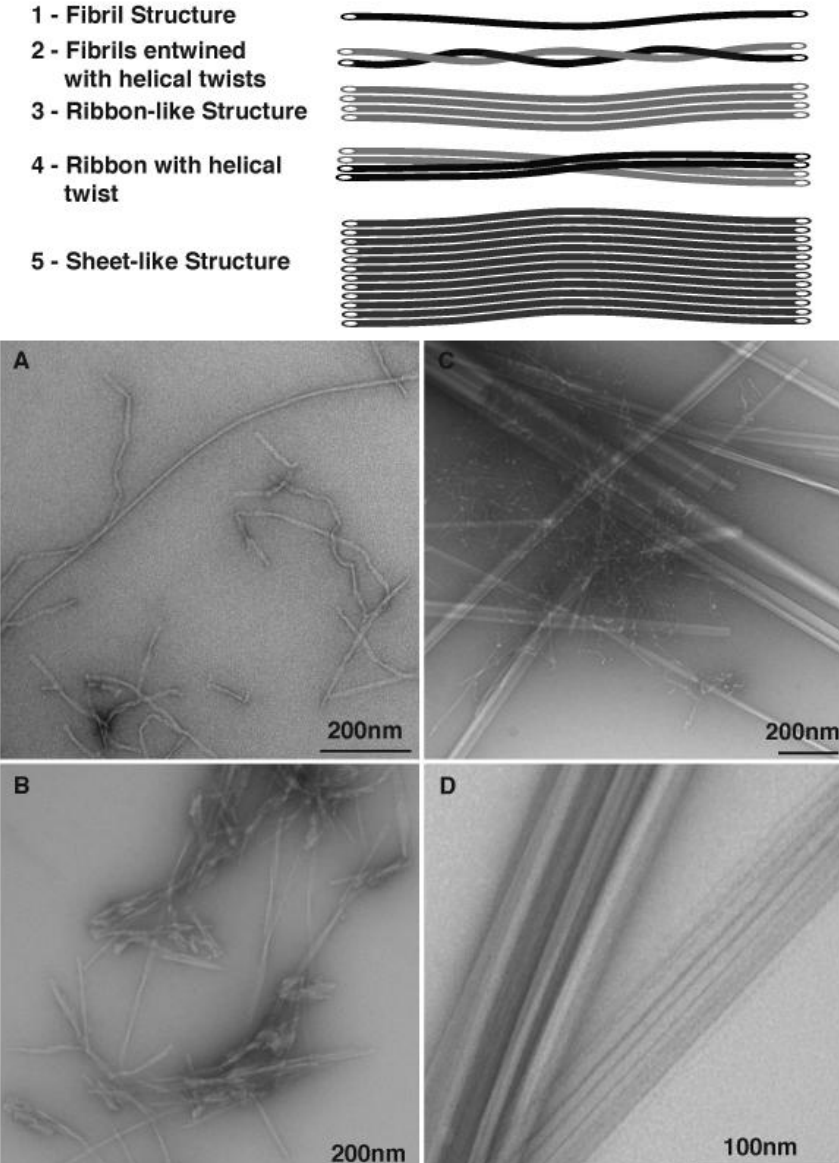
FIGURE 1. Fibril formation by human IAPP 1-37 (A), 8-37 (B), and 20-29 (C and D) peptides. Polymorphism of fibrillar forms was clearly evident for 1-37, 8-37, and 20-29. A range of fibrillar structures detailed in the schematic diagram was observed. The 1-37 and 8-37 forms contained a mixture of fibril and ribbon-like structures. The 20-29 form contained a diverse size range of fibrils and sheet-like tubules; at higher resolution, the sheets appear to be formed from cross-linked fibrils in a parallel alignment. The scale bars indicate 200 nm (A–C) or 100 nm